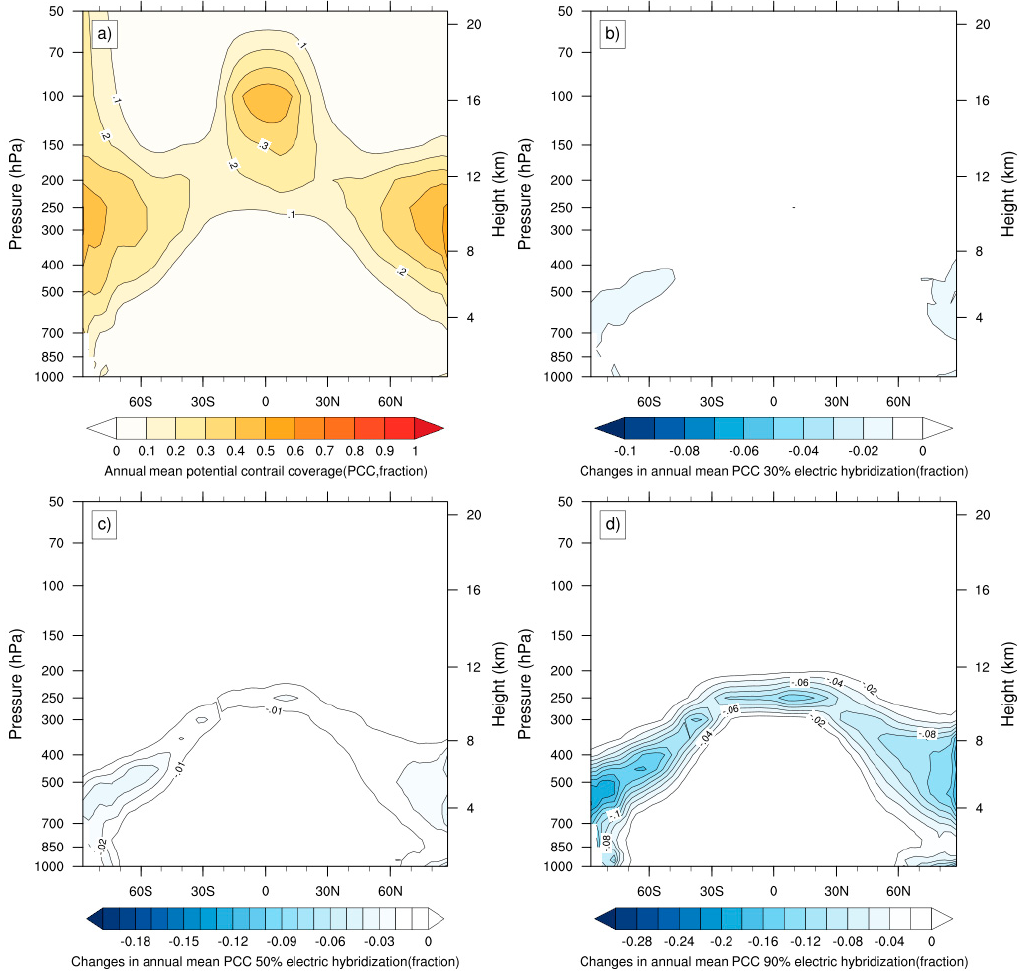
Figure 12. Annual zonal mean potential contrail coverage and changes due to electric hybridization: ( a ) conventional aircraft; ( b ) 30% electric hybridization; ( c ) 50% electric hybridization; ( d ) 90% electric hybridization.